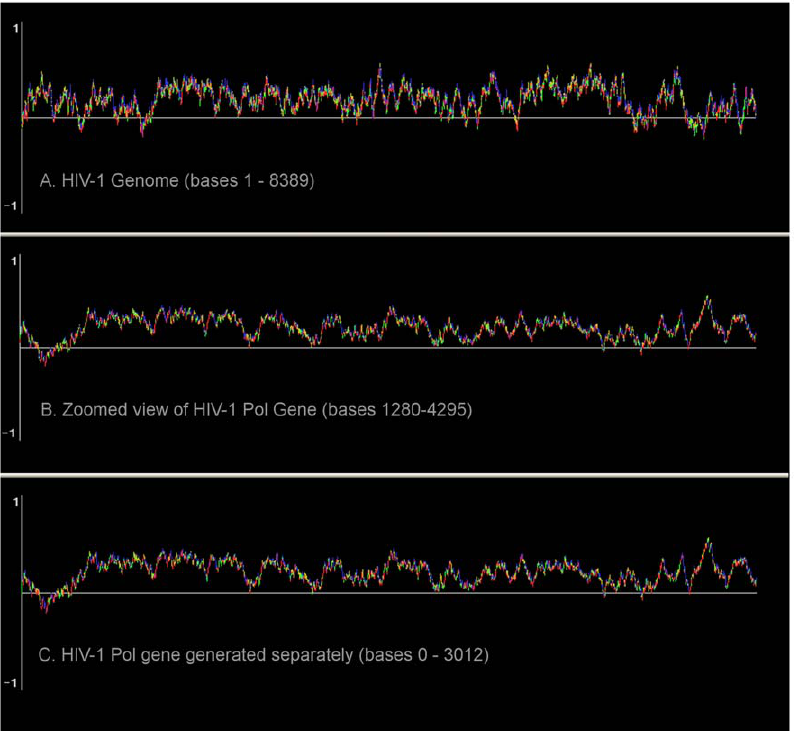
Figure 3. W-curves of a whole HIV-1 genome (A) and embedded pol gene sequence (B, C). A W-curve of an entire genome of HIV-1 01TH.OUR6091 (Accession number AY358040 is shown in panel A. Panel B shows a ‘‘zoomed in’’ projection of pol gene HIV-1 99 TH .OUR1991 (Accession number AY358039) with respect to base pair position in the whole genome. Panel C shows the same pol sequence extracted from the fasta file and renumbered with respect to base pair position. Sequences can be input into one of two graphical packages for the W-curve existing on the internet (10, 11).